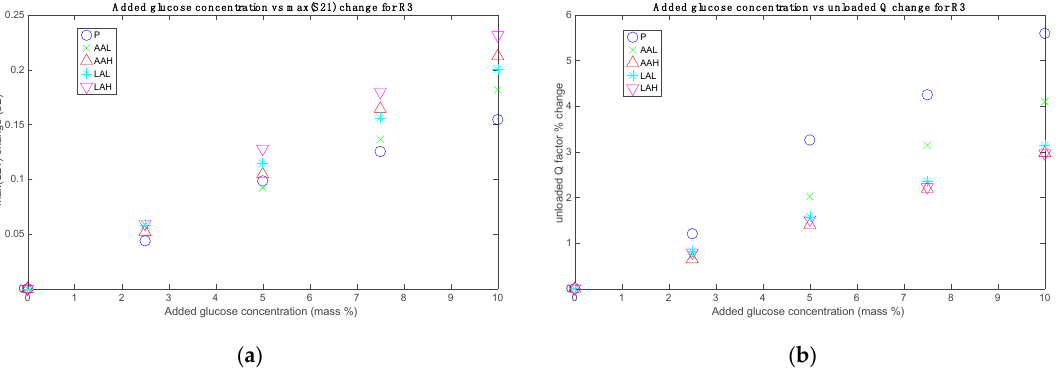
Figure 6. ( a ) Measurements with R3: absolute changes for S21 max ; ( b ) Measurements with R3: percentage changes for Q u .